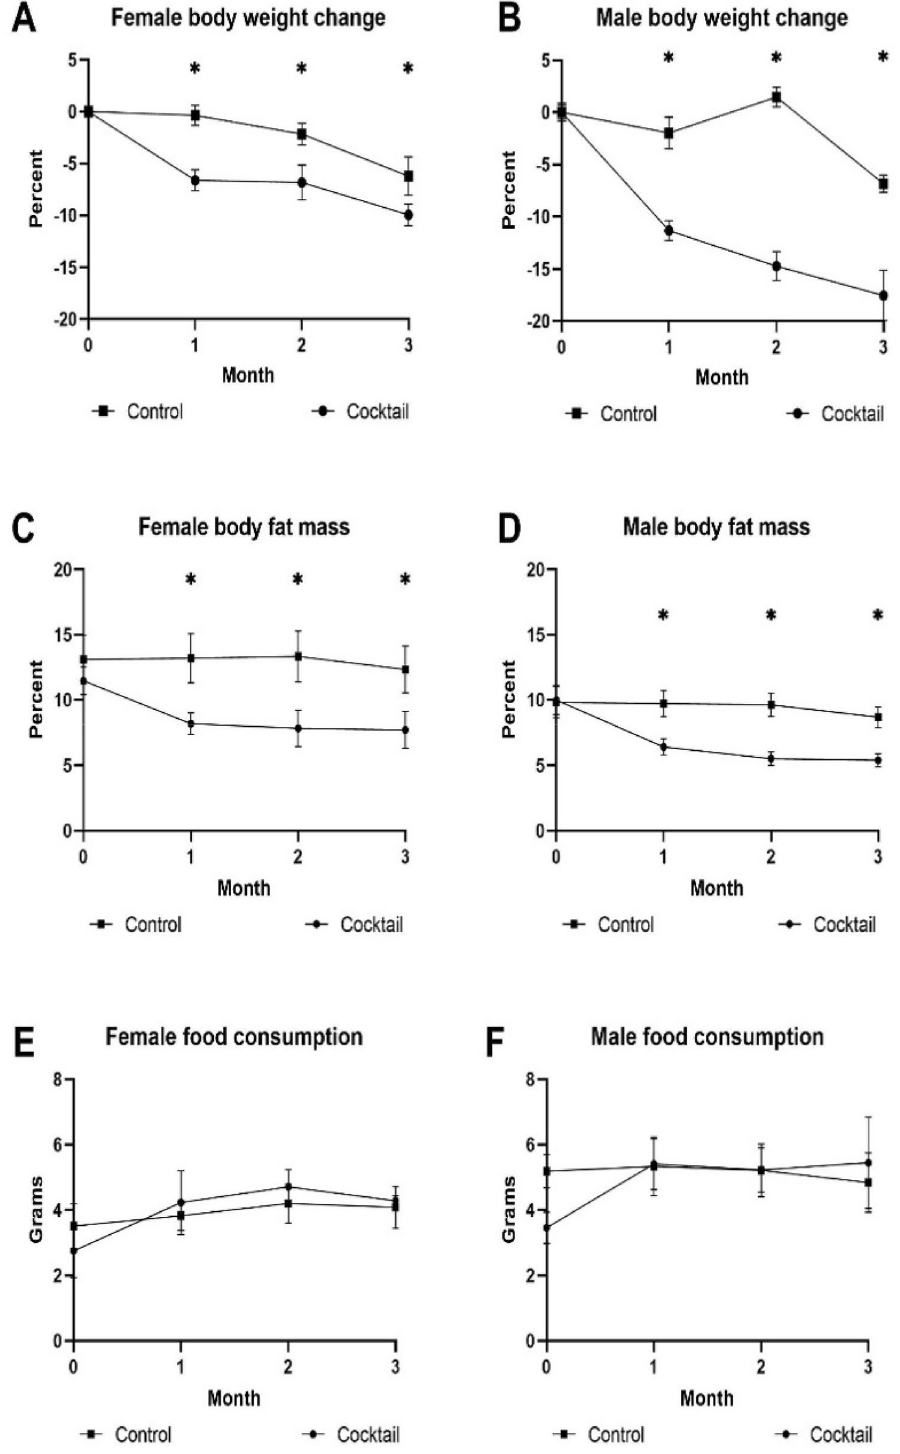
Figure 6. Biological parameters were assessed monthly in HET3 mice fed drug cocktail chow or chow with each individual drug or control for three months starting at 20 months of age. (A) Body weight in females, (B) body weight in males, (C) body fat mass measured by magnetic resonance imaging in females, (D) body fat mass measured by magnetic resonance imaging in males, (E) food intake measured over 3 days each month for females, (F) food intake measured over 3 days each month for males. N = 12–14/cohort. *P < 0.05; two-tailed, unpaired Student’s